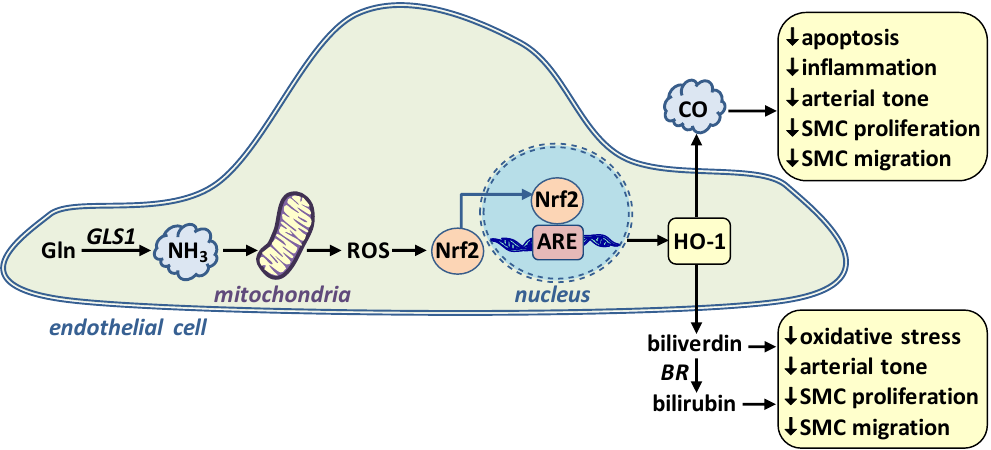
Figure 2. Role of l -glutamine (Gln)-derived ammonia (NH 3 ) in stimulating endothelial cell heme oxygenase-1 (HO-1) gene expression and maintaining vascular homeostasis. Gln is metabolized by glutaminase-1 (GLS1) to form the gas NH 3 . NH 3 stimulates the production of mitochondrial reactive oxygen species (ROS) which causes the activation and translocation of NF-E2-related factor-2 transcription factor (Nrf2) into the nucleus, where it binds to the antioxidant responsive element (ARE) in the promoter region of the gene to trigger HO-1 transcription. HO-1 catalyzes the conversion of heme to carbon monoxide (CO) and biliverdin, the latter being rapidly metabolized to bilirubin by biliverdin reductase (BR). CO and the bile pigments (biliverdin and bilirubin) promote vascular homeostasis by inhibiting apoptosis, oxidative stress, inflammation, arterial tone, and vascular smooth muscle cell (SMC) proliferation and migration.